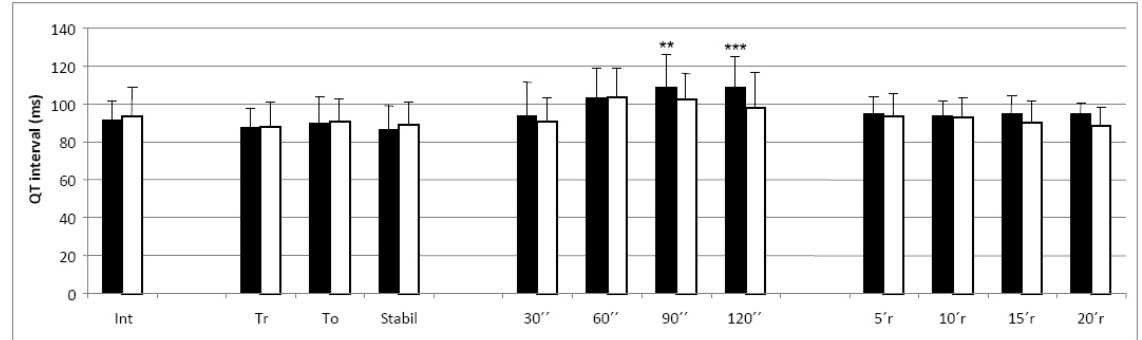
Figure 4. Mean ± SD values of the QT-interval duration in intact animals (Int), after tracheotomy (Tr), thoracotomy (To), 5 minutes after stabilization (Stabil), in each 30 seconds of a 2-minute apnoeic episode, and after 5, 10, 15, and 20 minutes of artificial reoxygenation. Empty and black columns refer to light and dark parts of the day, respectively. The level of significance of differences between the light and dark part of the rat daily regimen is indicated by the symbol (* p < 0.05, ** p < 0.01, *** p <